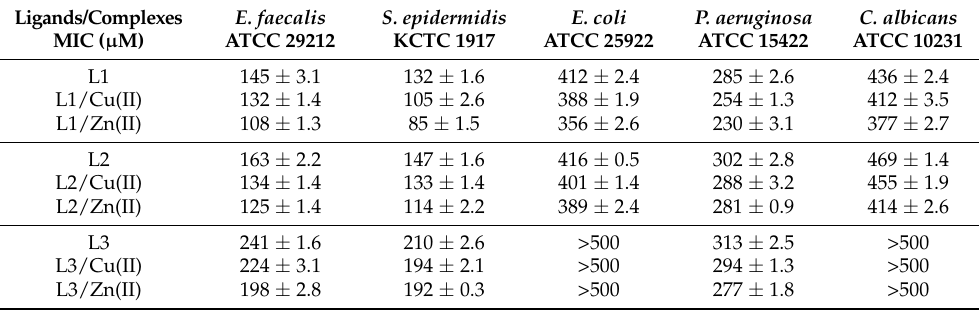
Table 1. Antimicrobial activity of KSAFELPHYGLLAHQ (L1), KSHFELPAYGLLAHQ (L2), KSHFEL- PHYGLLAHQ (L3), and their metal(II) complexes against pathogenic microorganisms. Values are the average of three independent experiments performed in three